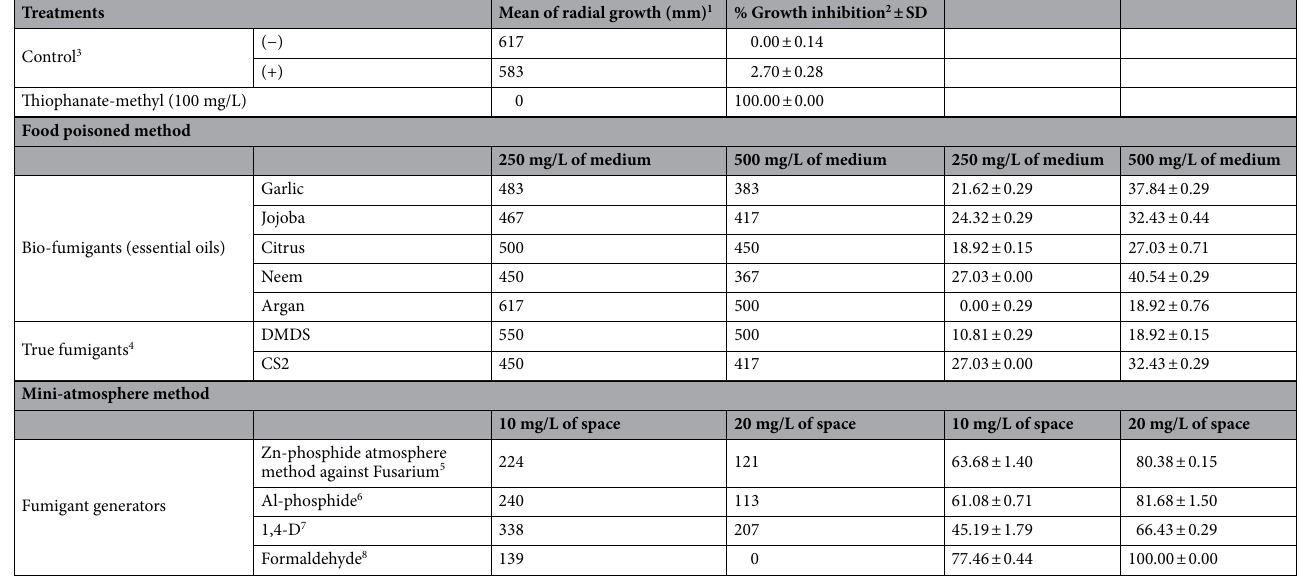
Table 1. Effect of tested true- and bio-fumigants using food poisoned method and fumigant generators using mini-atmosphere method against Fusarium grown in PDA medium at 7th day. 1 The values represent the mean of the 5 replicates. 2 Growth inhibition (%) = ((Growth in control − Growth in treatment)/Growth in control) × 100. 3 Control (−) containing water, control (+) containing (1 mL Triton-X 100 + 1 mL DMSO)/L of medium. 4 Dimethyl disulphide (DMDS), Carbon disulphide (CS 2 ). 5 Zn-phosphide was mixed with HCl 1N (1:5), 1 mg Zn-phosphide produces 0.24 mg PH 3 . 6 Al-phosphide was mixed with HCl 1 N (1:5), 1 mg AL-phosphide produces 0.32 mg PH 3 . 7 It was generated from 1,4-dichlorobenzene (100%). 8 Formaldehyde was generated from formalin 40% + KMnO 4 (1:3), 1 mL formalin produces 0.40 g formaldehyde.